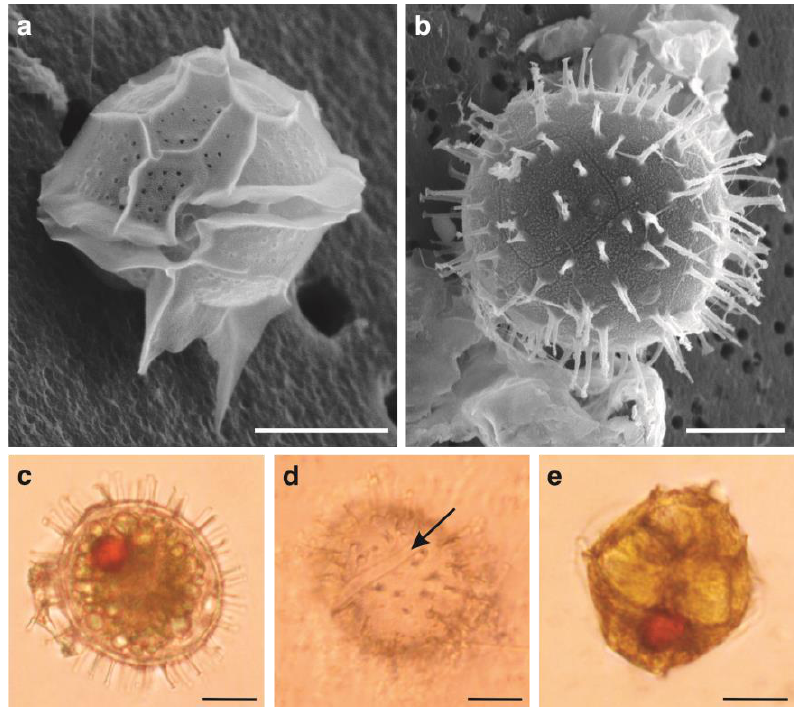
Figure 2. Pyrodinium bahamense under scanning electron ( a , b ) and light microscopy ( c – e ). ( a ) Single vegetative cell in ventral view; ( b ) dorsal view of cyst showing apical and precingular plates; ( c ) living whole cyst showing the red accumulation body; ( d ) empty cyst showing an archeopyle (arrow); ( e ) motile cell with theca in development showing the red accumulation body. Scale bars = 20 µ